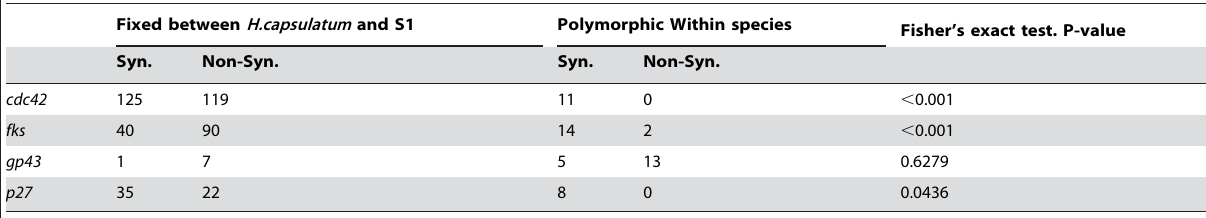
Table 3. McDonald-Kreitman tests of neutrality.